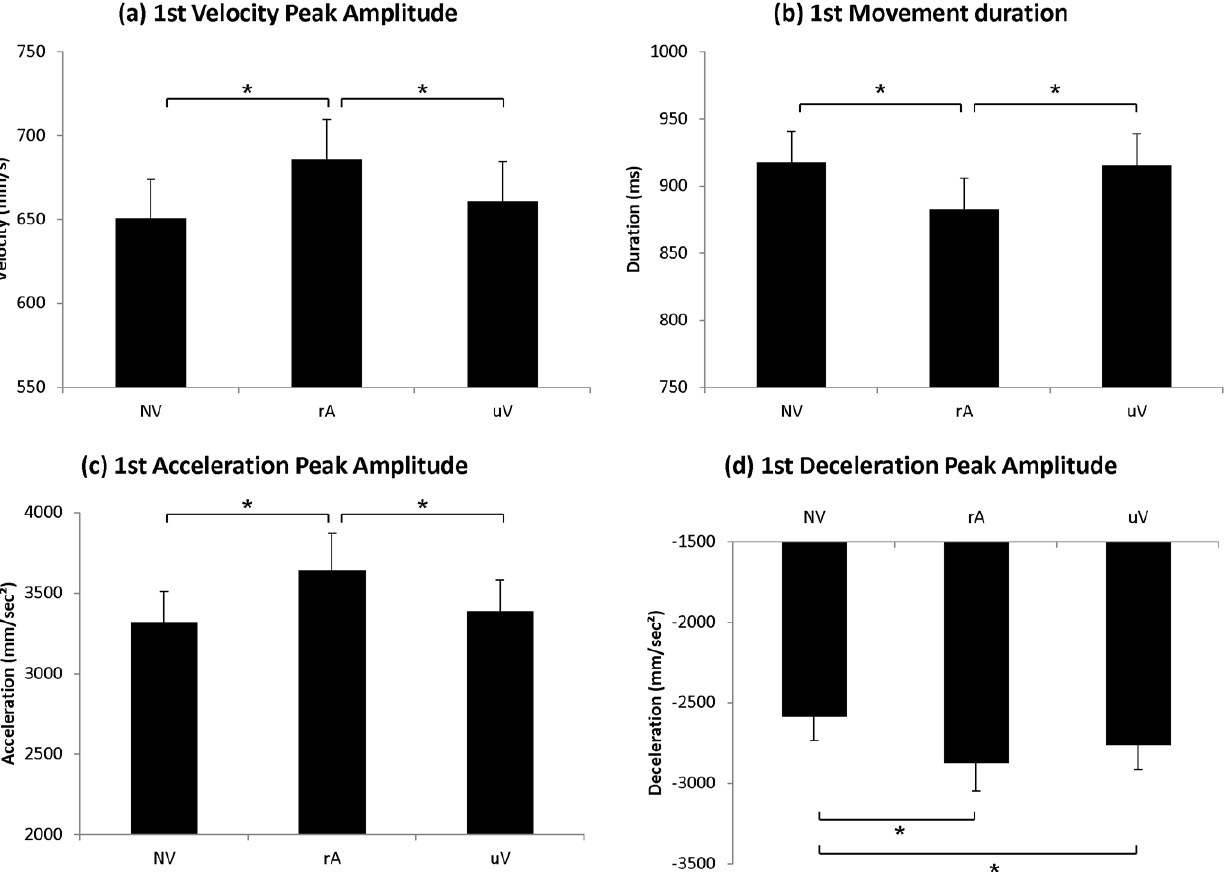
Figure 3. Experiment I: Kinematic parameters of the ‘‘Reach-to Grasp’’ movement. Mean values of (a) wrist velocity peak amplitude (b) movement duration (c) wrist acceleration peak amplitude and (d) wrist deceleration peak amplitude. Error bars represent standard error of the mean (SEM). *p , 0.05.